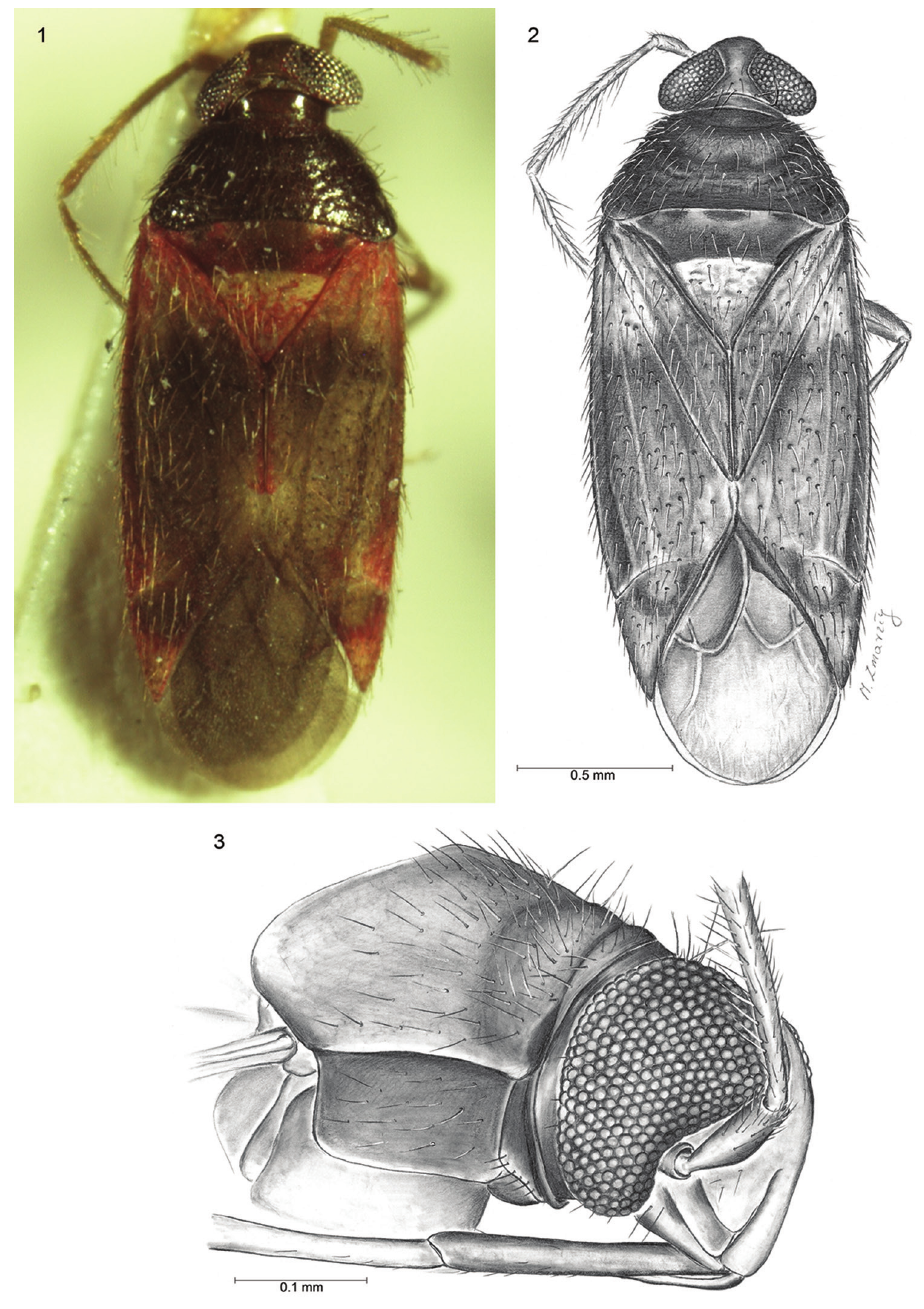
Figures 1–3. 1, 2 Psallus coloratus sp. n. 1 Photograph of dorsal view 2 Drawing of dorsal view 3 Lateral drawing of head. Scale bars: 1, 2 = 0.5 mm; 3 = 0.1